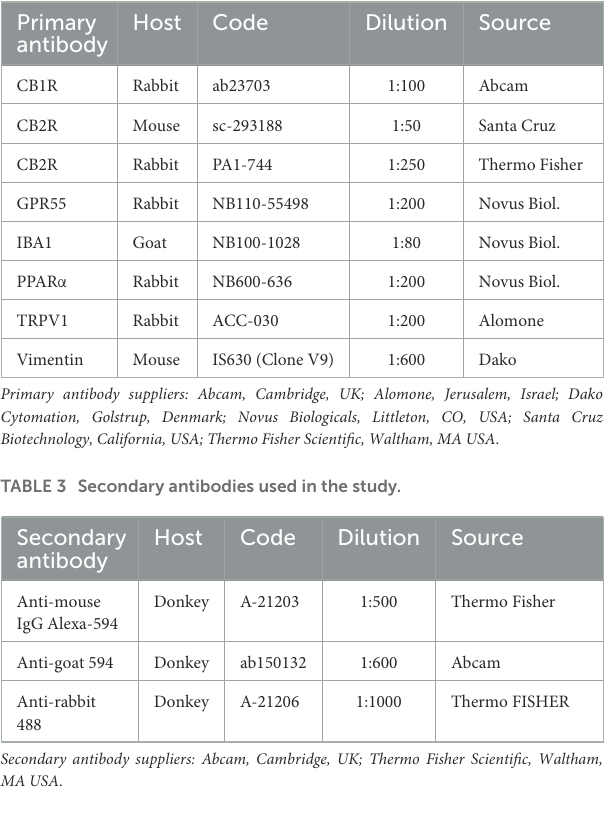
TABLE 2 Primary antibodies used in the study.